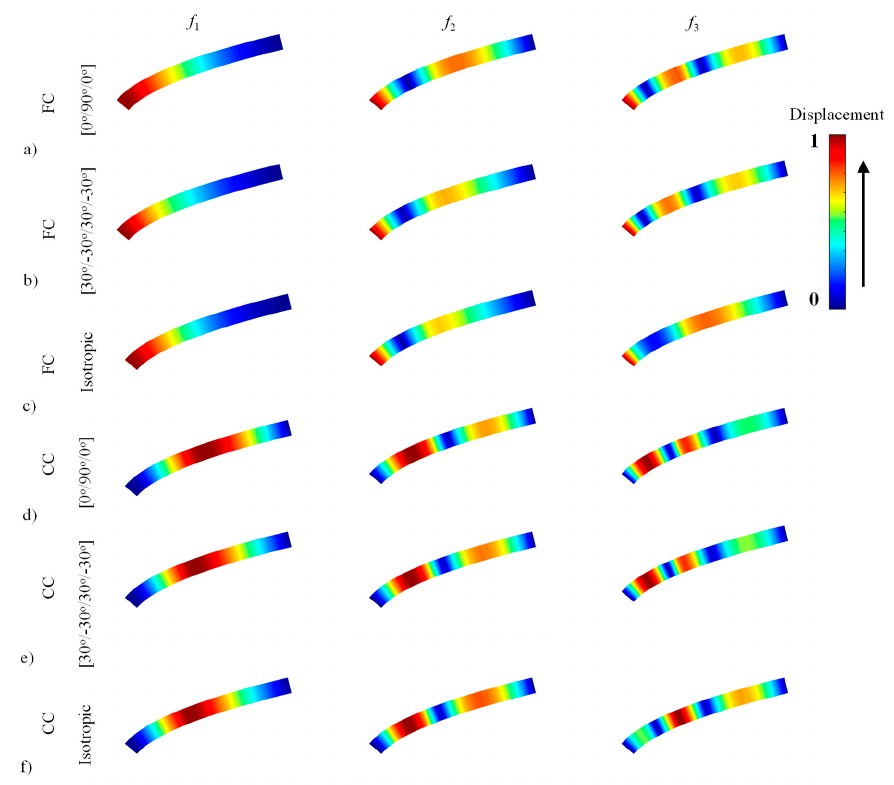
Figure A3. Several mode shapes for a hyperbolical composite laminated beam and a hyperbolical isotropic beam.